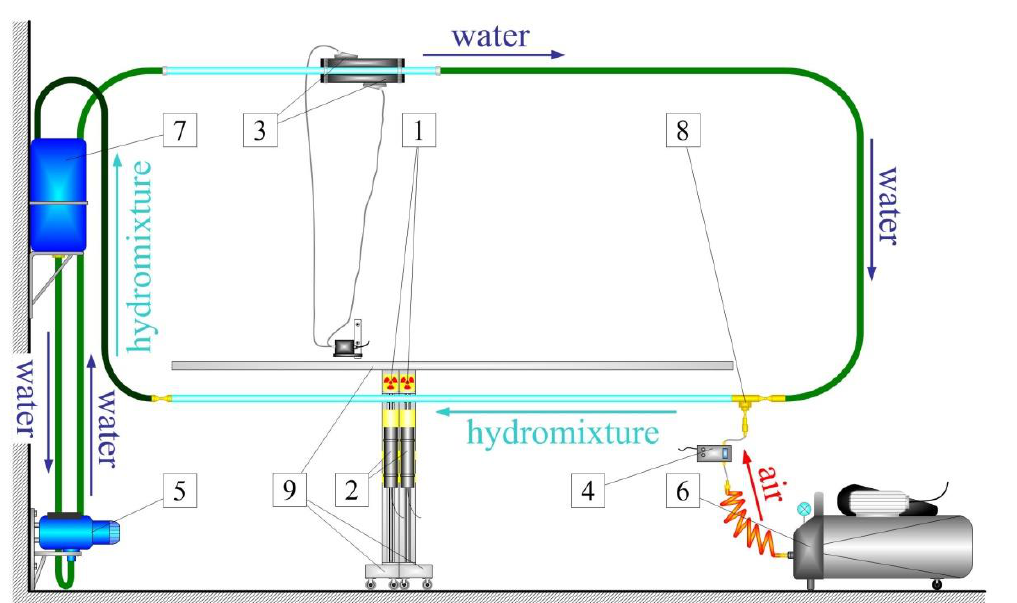
Fig. 1. Schema of laboratory experimental set-up: 1 –sealed Am-241 sources with collimators, 2 – scintillation probes, 3 – ultrasonic flow meter of water, 4 – mass flow meter of air, 5 – pump with power inverter, 6 – compressor 50l, 7 – expansion tank, 8 – injector, 9 – shift system.